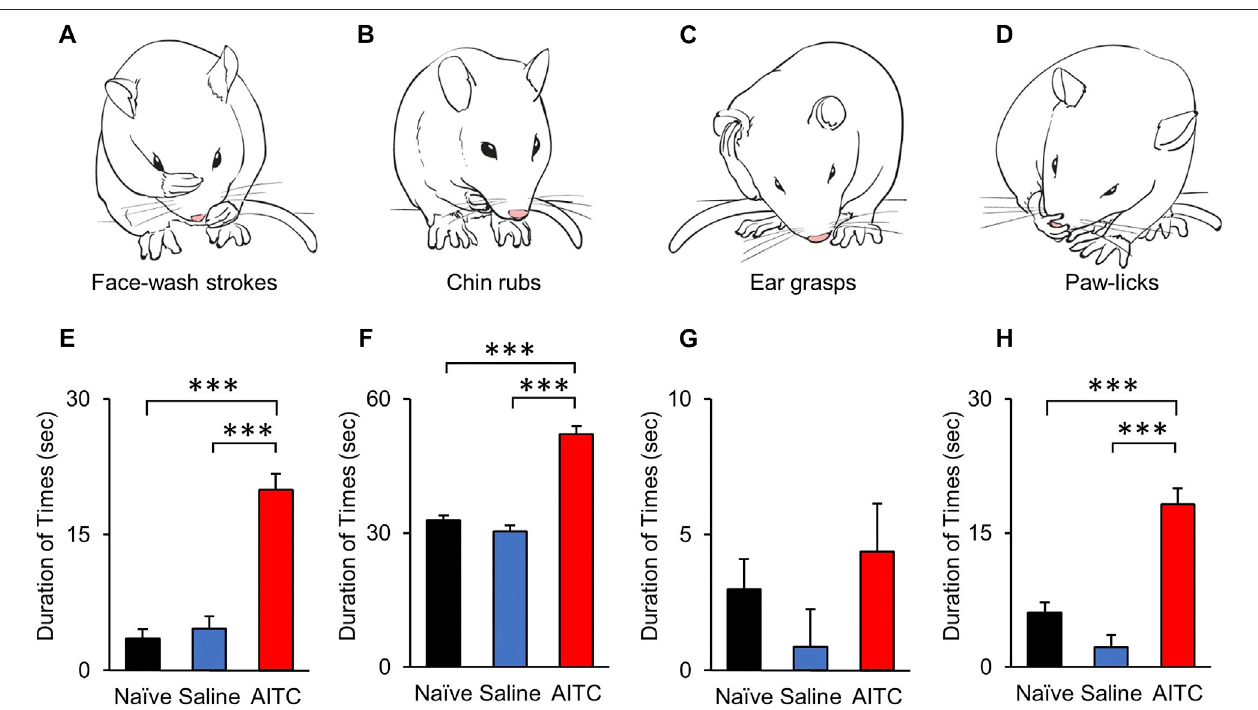
FIGURE2| BehavioralanalysisafterAITC-inducedpulpitis. (A – D) AITC-inducedfacegroomingbehaviors(face-washing,chin-rubs,eargrasps,andpaw-licks)are illustrated and compared with naïve and saline-treated groups. Each graph show the duration time of grooming behaviors, face-washing (E) , chin-rubs (F) , ear grasps (G) , and paw-licks (H) . Histograms indicate the comparison of naïve, saline-, and AITC-treated rats behaviors. Signi fi cant increases were observed in the durations of face-washing,chinrubbing,andpawlickinginAITC-treatedratscomparedwithnaïveandsaline-treatedrats(ErrorbarsrepresentSEM;*** p < 0.001, n (cid:1)